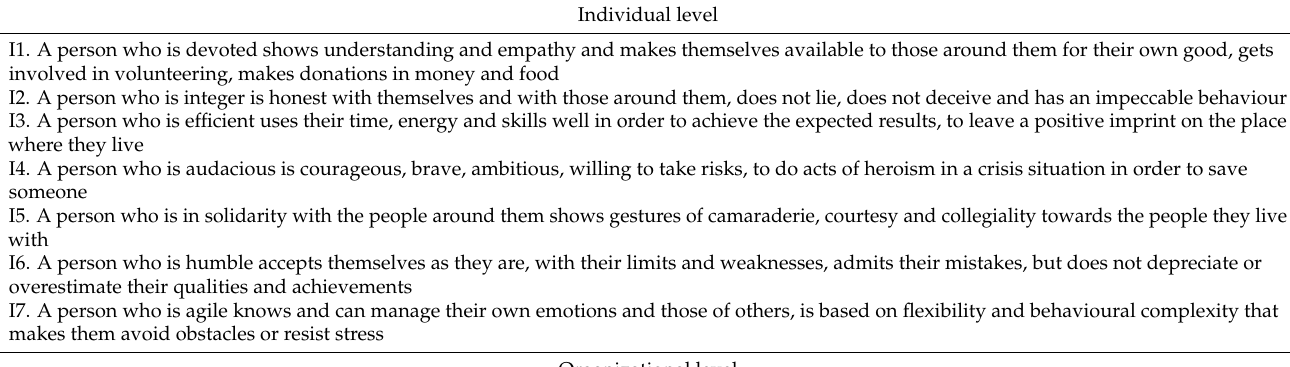
Table A1. Descriptions of the traits used in the evaluation